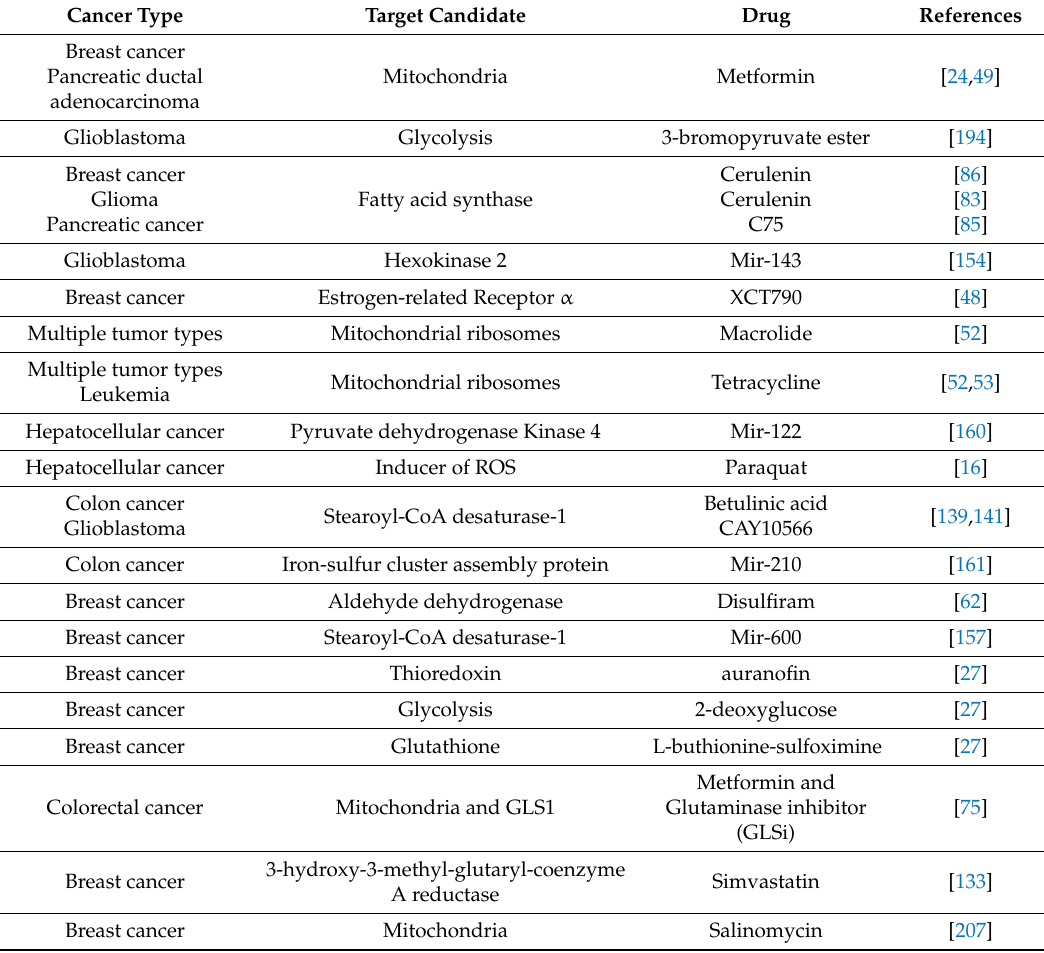
Table 2. Metabolic Therapeutic Targets of Cancer Stem